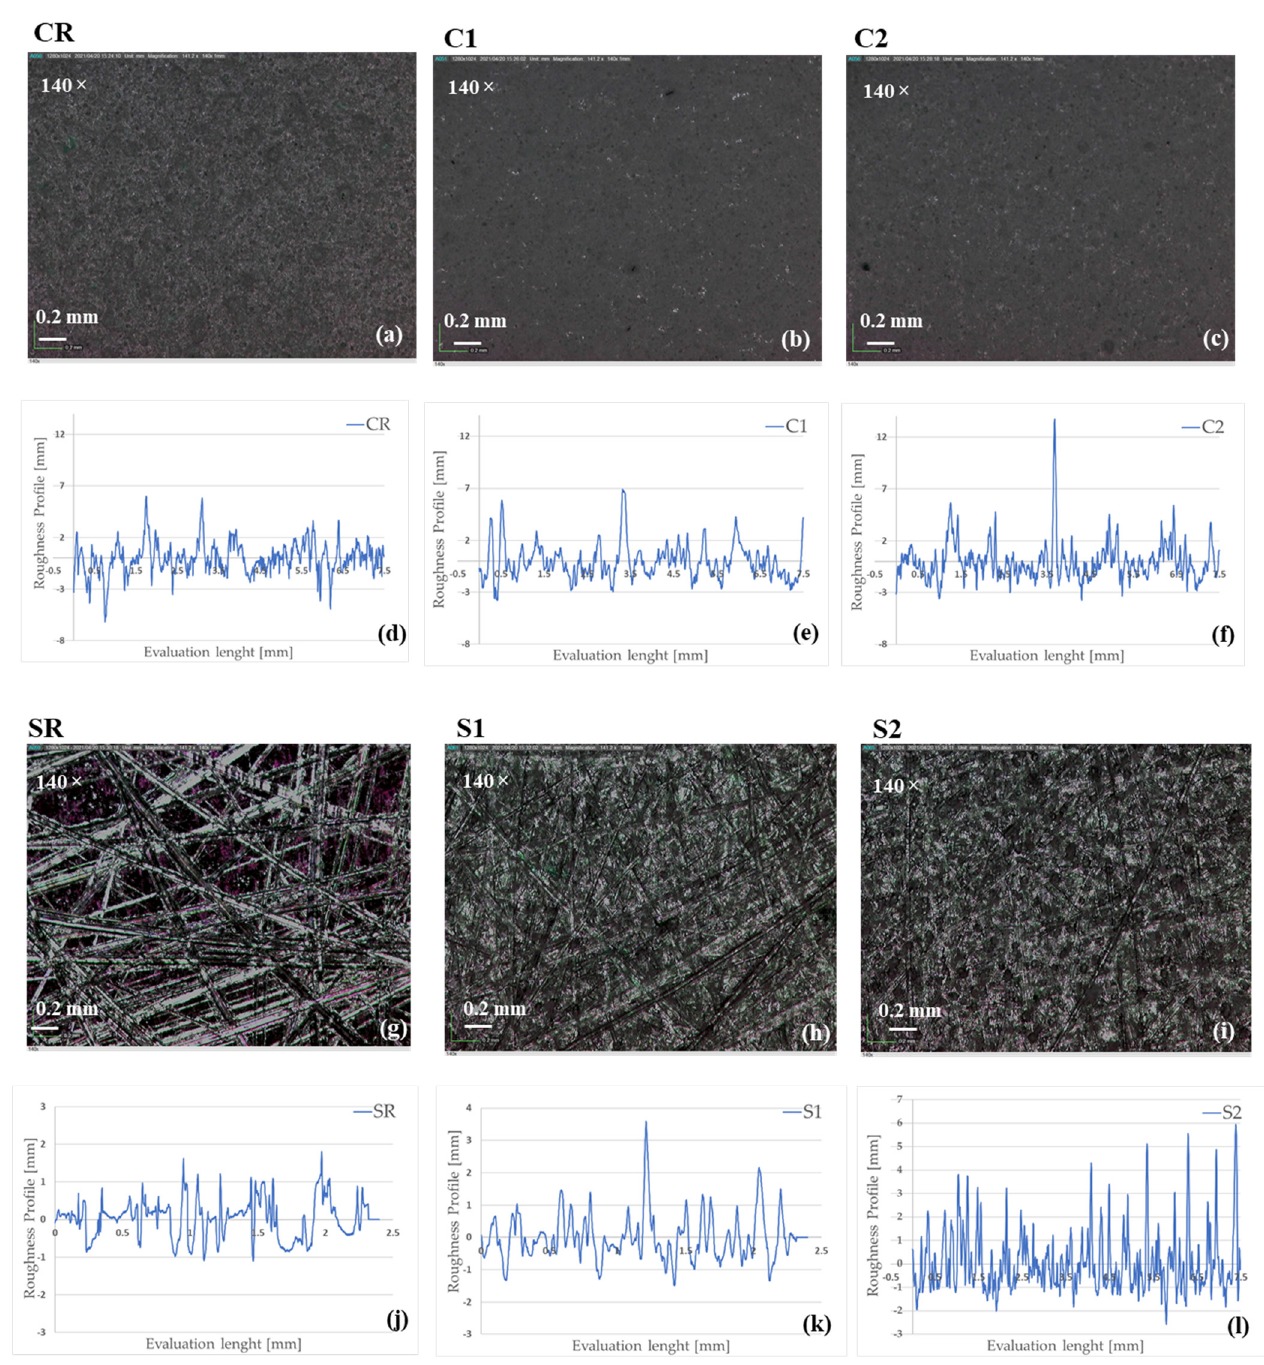
Figure 4. Optical microscopy images acquired at 140× of CR ( a ), C1 ( b ), C2 ( c ), SR ( g ), S1 ( h ), and S2 ( i ) samples’ surfaces, and the corresponding roughness profiles for CR ( d ), C1 ( e ), C2 ( f ), SR ( j ), S1 ( k ), and S2 ( l ).